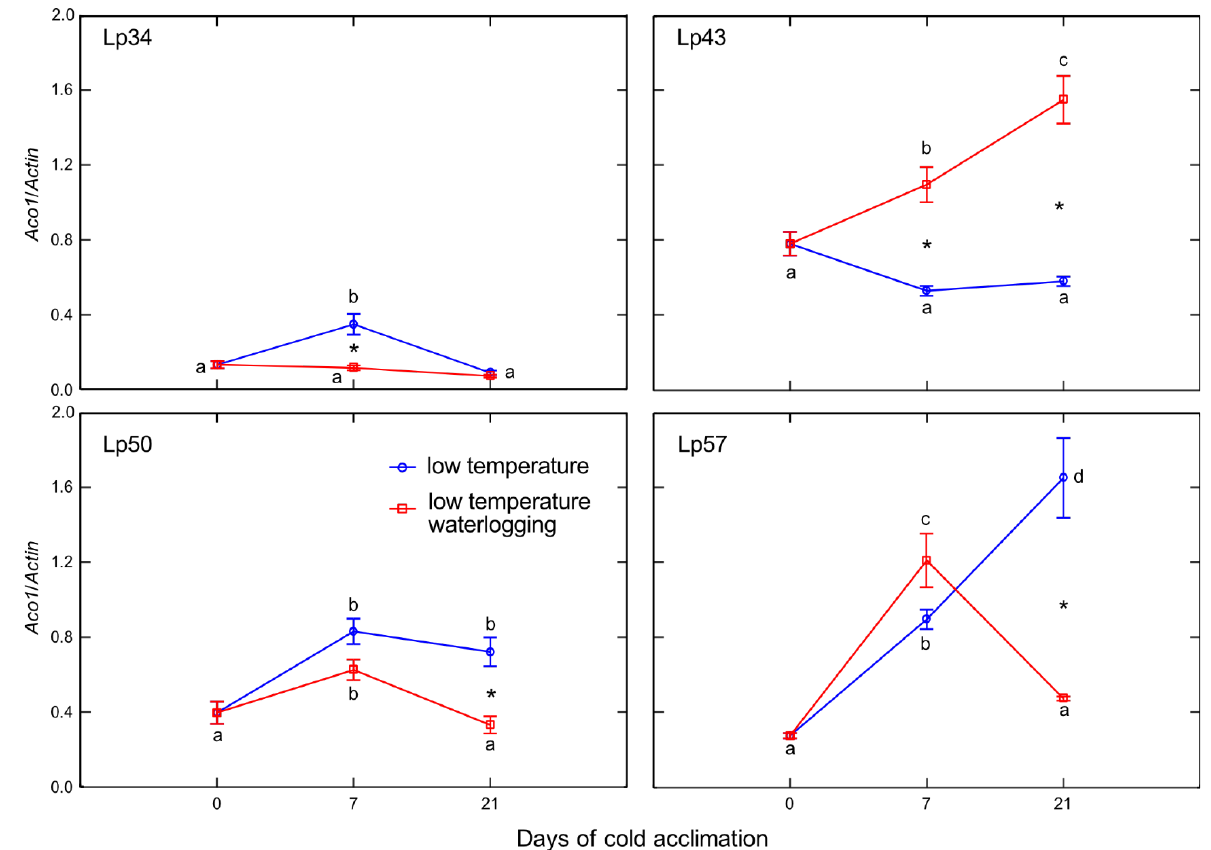
Figure 10. Relative transcript level of Aco 1 of cold-acclimated Lolium perenne genotypes. Four genotypes (Lp34, Lp43, Lp50, and Lp57) were tested. The transcript level was calculated using Actin as a reference gene. The results are means ( n = 4), error bars indicate the standard error. Asterisks indicate means that differ significantly between waterlogged and control plants according to one-way ANOVA ( p < 0.05). Different lower-case letters indicate means that are statistically different according to Duncan ’s multiple range test ( p < 0.05).